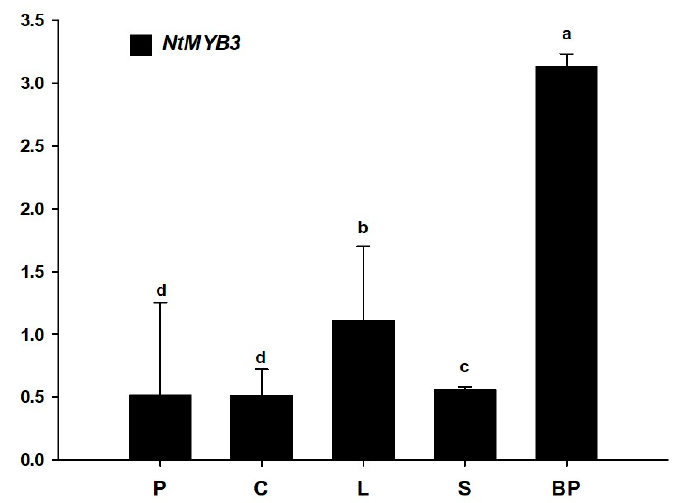
Figure 8. Different tissues and organs of Chinese narcissus used in this experiment. Figure 9. Expression analysis of NtMYB3 in various tissues of Narcissus tazetta . P, C, L, S, and BP indicate the petals, corona, leaves, bulb scales, and basal plates, respectively. Small letters showed the significant difference among different tissues at the level of p < 0.05 by using LSD test. Bars showed the standard error of three replicates.